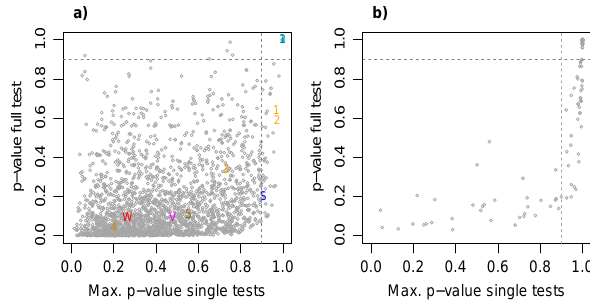
Fig. B1. Surrogate ensemble (SUR): (a) Testing against 2201 surrogate targets: p values for the full goodness-of-fit χ 2 test plotted against the maximum of the p values obtained from the tests for bias and spread deviations. In (a) orange (blue, see top right corner) numbers 1–5 (1–3) give values for the WSIM (SSIM) full-forcing simulations with weak (strong) solar forcing; red W , blue S and magenta V show values for weak and strong solar forcing only and volcanic only simulations. No uncertainties are considered in (a) . (b) as in (a) but for the test against the 521 members of the Frank et al. (2010) ensemble (FRA) as targets. Horizontal and vertical lines indicate a conservative 90% level for significance against the null hypothesis of a uniform rank histogram. (b) accounts for uncertainties and reduced internal variability in data by Hegerl et al. (2007), Mann and Jones (2003) and Mann et al. (2008).